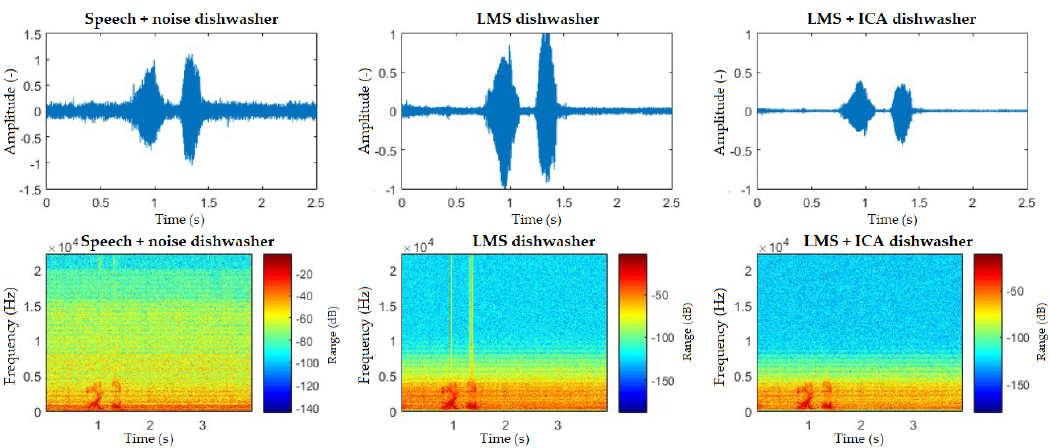
Figure 13. Comparison of spectrograms with closed windows, “light on” command, dishwasher interference.